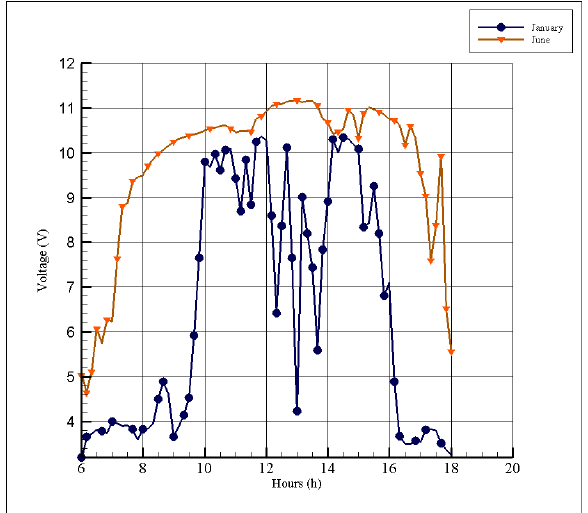
Figure 8. The hourly electric production in January and June (for 16 elements).